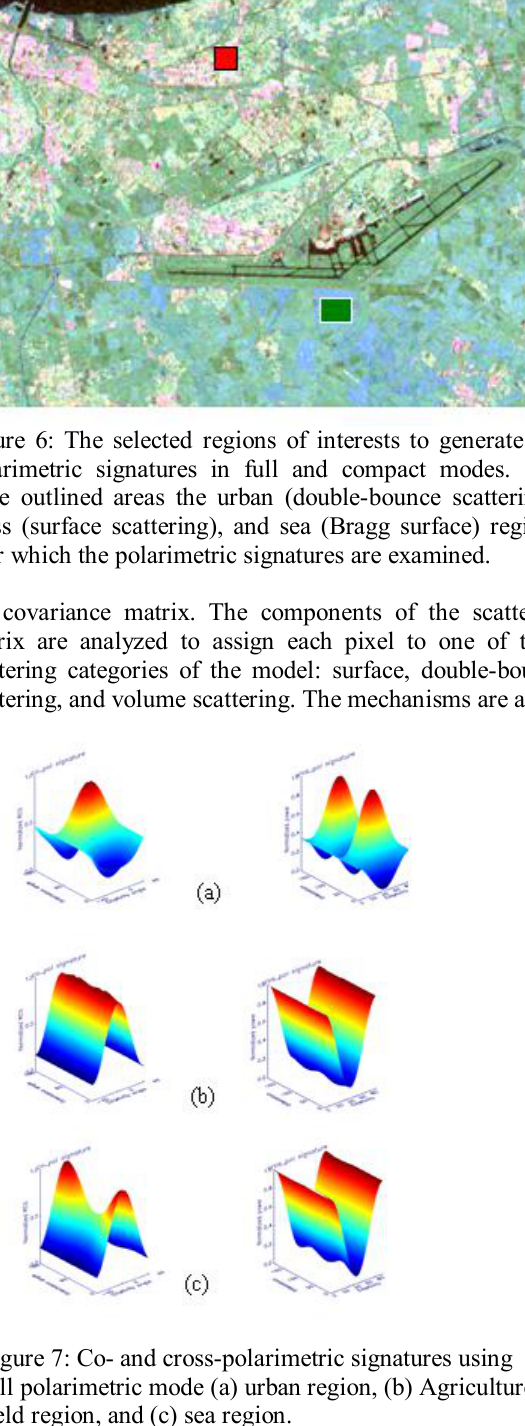
Figure 8: Co- and cross-polarimetric signatures using compact polarimetric mode (a) urban region, (b) Agriculture field region, and (c) sea